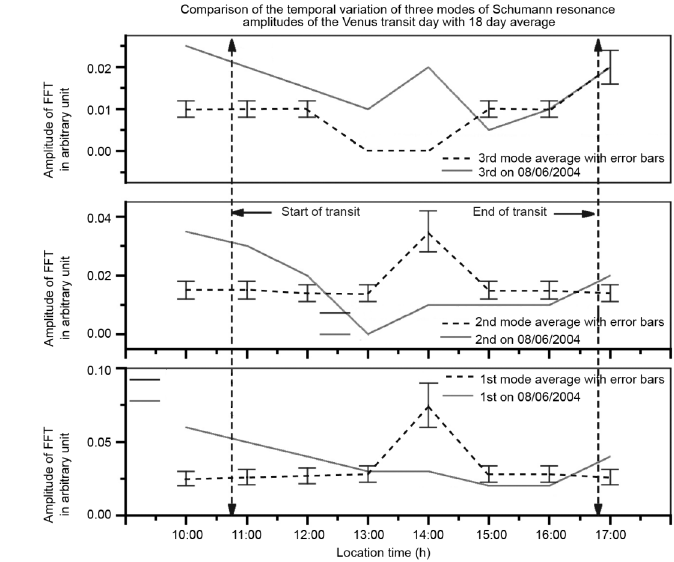
Fig. 1. Variation of peak magnetic amplitude of the three modes of Schumann resonance spectra on the day of Venus transit, 8th June 2004 (continuous line) and average variation of the same parameter around 8th June for 18 days (dotted